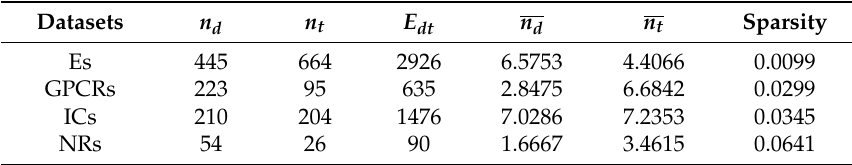
Table 5. Statistics of four drug-target interaction